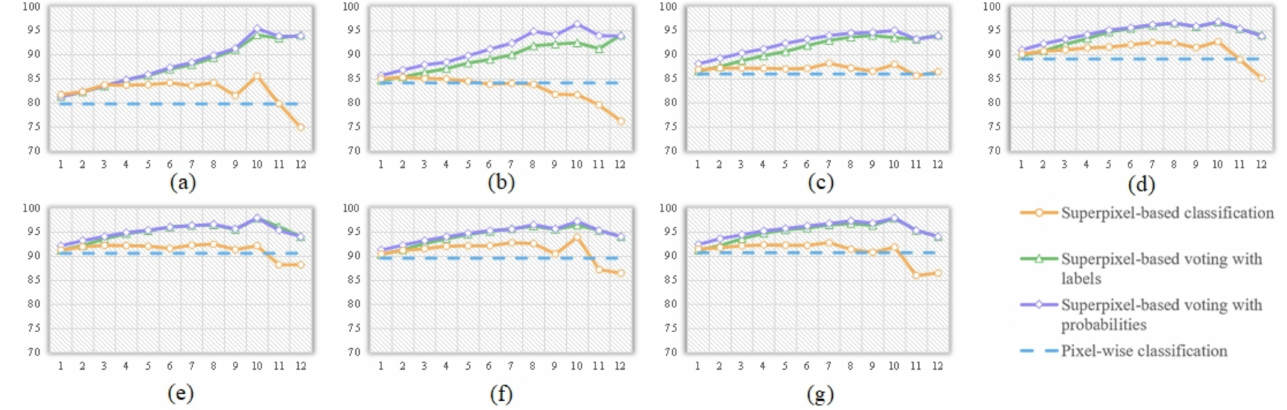
Figure 8. Accuracies given by the single-scale approaches with ( a ) 25, ( b ) 50, ( c ) 100, ( d ) 150, ( e ) 200, ( f ) 250, and ( g ) 300 training samples per class for the Longkou dataset using RF, where the vertical axis represents the OAs, and the horizontal axis represents the superpixel segmentation scale.